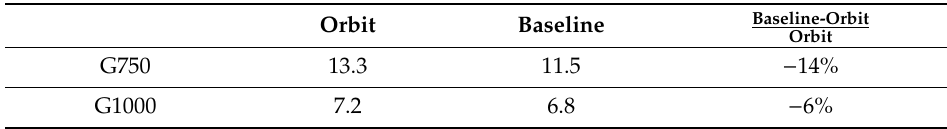
Table 3. Weighted mean of the gridded RMS di ff erences of mass anomalies (cm) with respect to consistently filtered WHU RL01 solutions, for di ff erent GPS-based